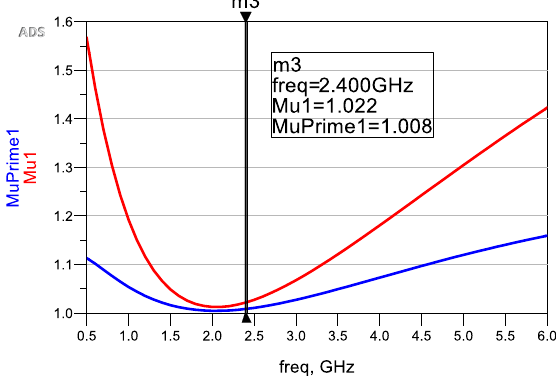
Fig. 3. Stability factors curves from 0.5 GHz to 6.0